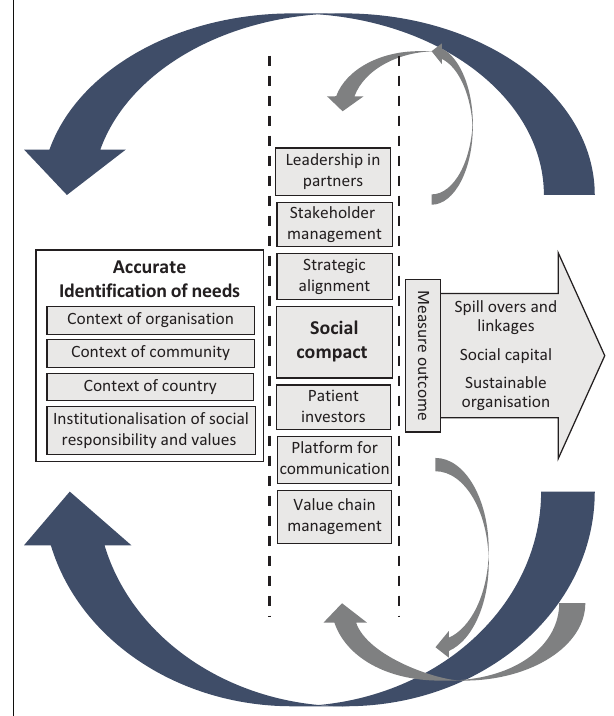
FIGURE 1: Schematic representation of consolidation of themes from all three research questions (grey = information, dark blue = value).